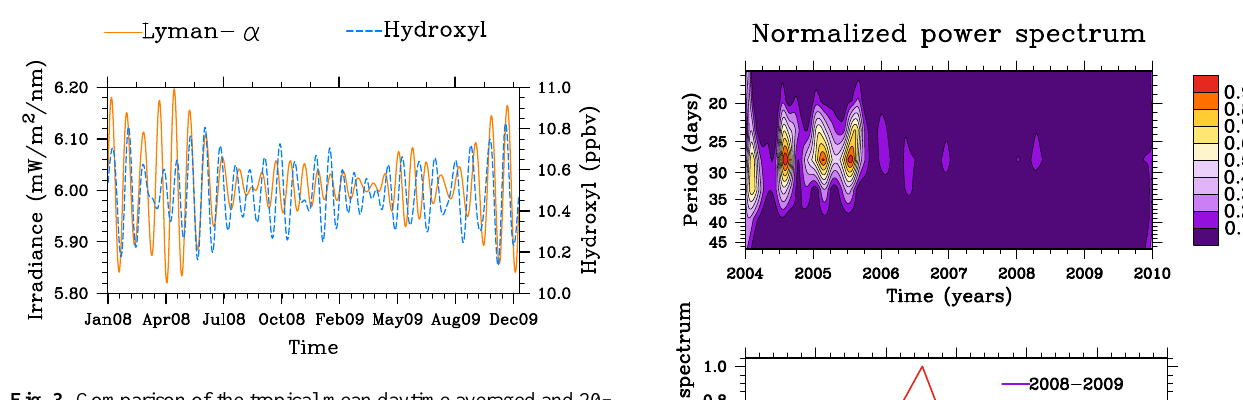
Fig. 3. Comparison of the tropical mean daytime averaged and 20– 35 day filtered MLS OH at ∼ 78km altitude with SOLSTICE Ly- α line irradiance for 2008–2009.